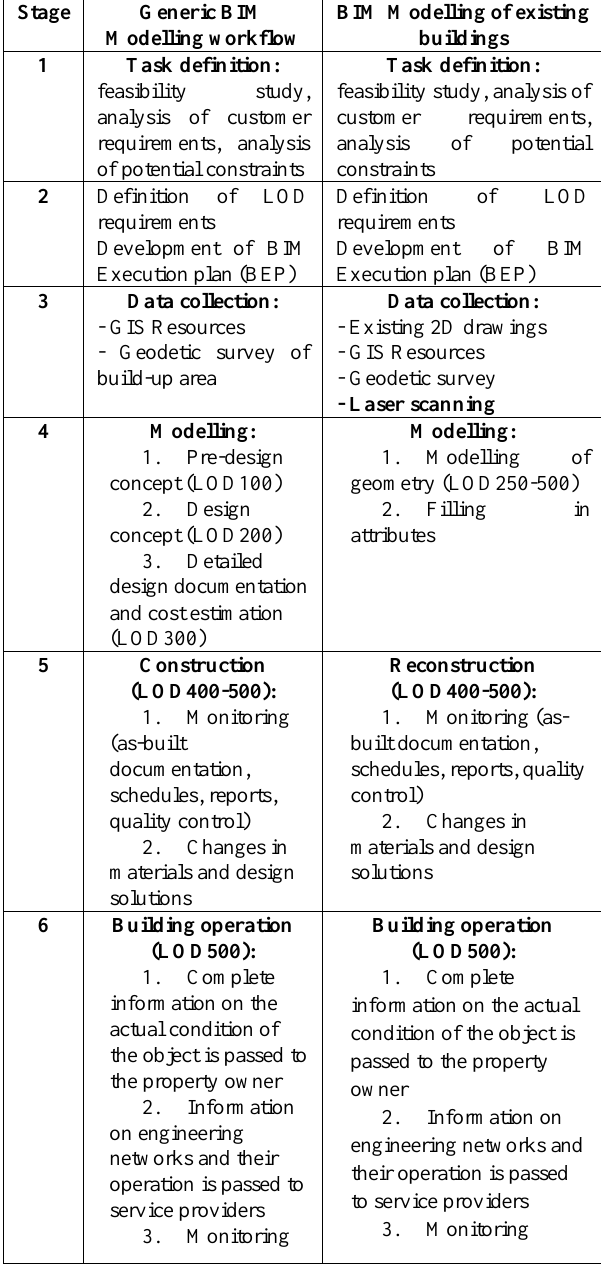
Table 1 . Comparison of BIM Modelling approaches for general case and for existing